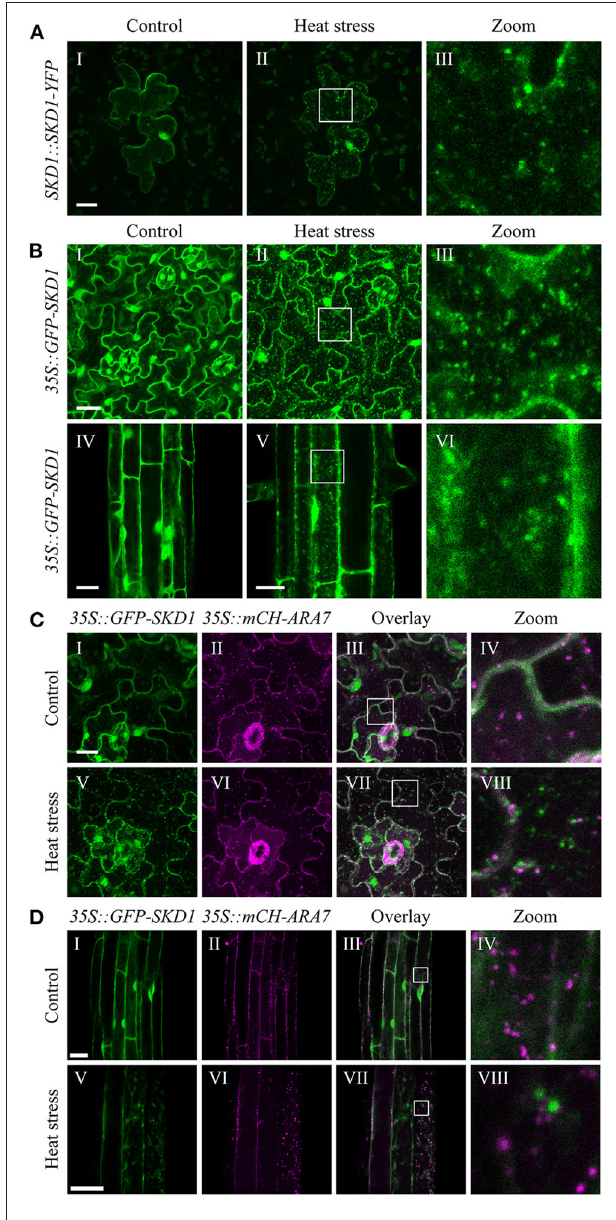
FIGURE 1 | Subcellular localization of SKD1 before and after heat treatment. (A) Representative epidermal leaf cell transiently expressing SKD1-YFP under the control of a 1.2kb upstream sequence of the AtSKD1 gene ( SKD1::SKD1-YFP ). Images are maximum projections of confocal stacks of the same cell before (I) and immediately after (II) heat stress treatment (40 ◦ C, 50min). Laser intensity was kept constant between images and higher magnifications of the boxes are indicated (III). (B) Subcellular localization of GFP-SKD1 in leaf (I–III) and root (IV–VI) epidermal cells of transgenic Col-0 seedlings ( 35S::GFP-SKD1 ). Plants were grown for 7d on vertically placed ½ MS plates and the same leaves and roots, but not the exact same areas were imaged before and after heat treatment. For leaf cells, maximum projections of stacks are depicted. For root cells, single-plane pictures are shown. Leaf (C) and root (D) epidermal cells of a transgenic Col-0 line co-expressing GFP-SKD1 and mCH-ARA7 ( 35S::GFP-SKD1x35S::mCH-ARA7) were analyzed for co-localization before (I–IV) and after (V–VIII) heat treatment. Co-localization of signals appears white in the overlay. Scale bar = 20 µ